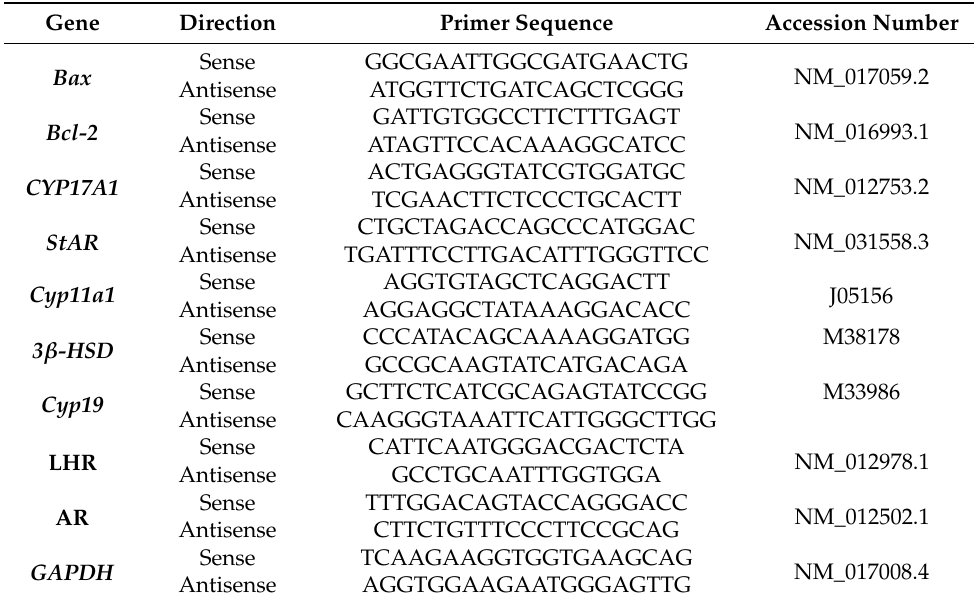
Table 1. Primers for gene expression by